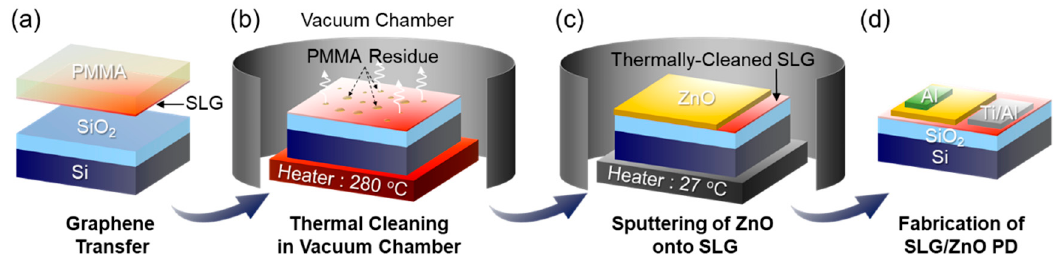
Figure 1. Schematic illustration for the fabrication of the ZnO / SLG Schottky PD: ( a ) SLG transfer step, ( b ) in situ thermal cleaning of SLG in vacuum sputtering chamber, ( c ) sputtering deposition of ZnO onto thermally-cleaned SLG, and ( d ) fabrication of the ZnO / SLG Schottky PD via lithographic techniques.